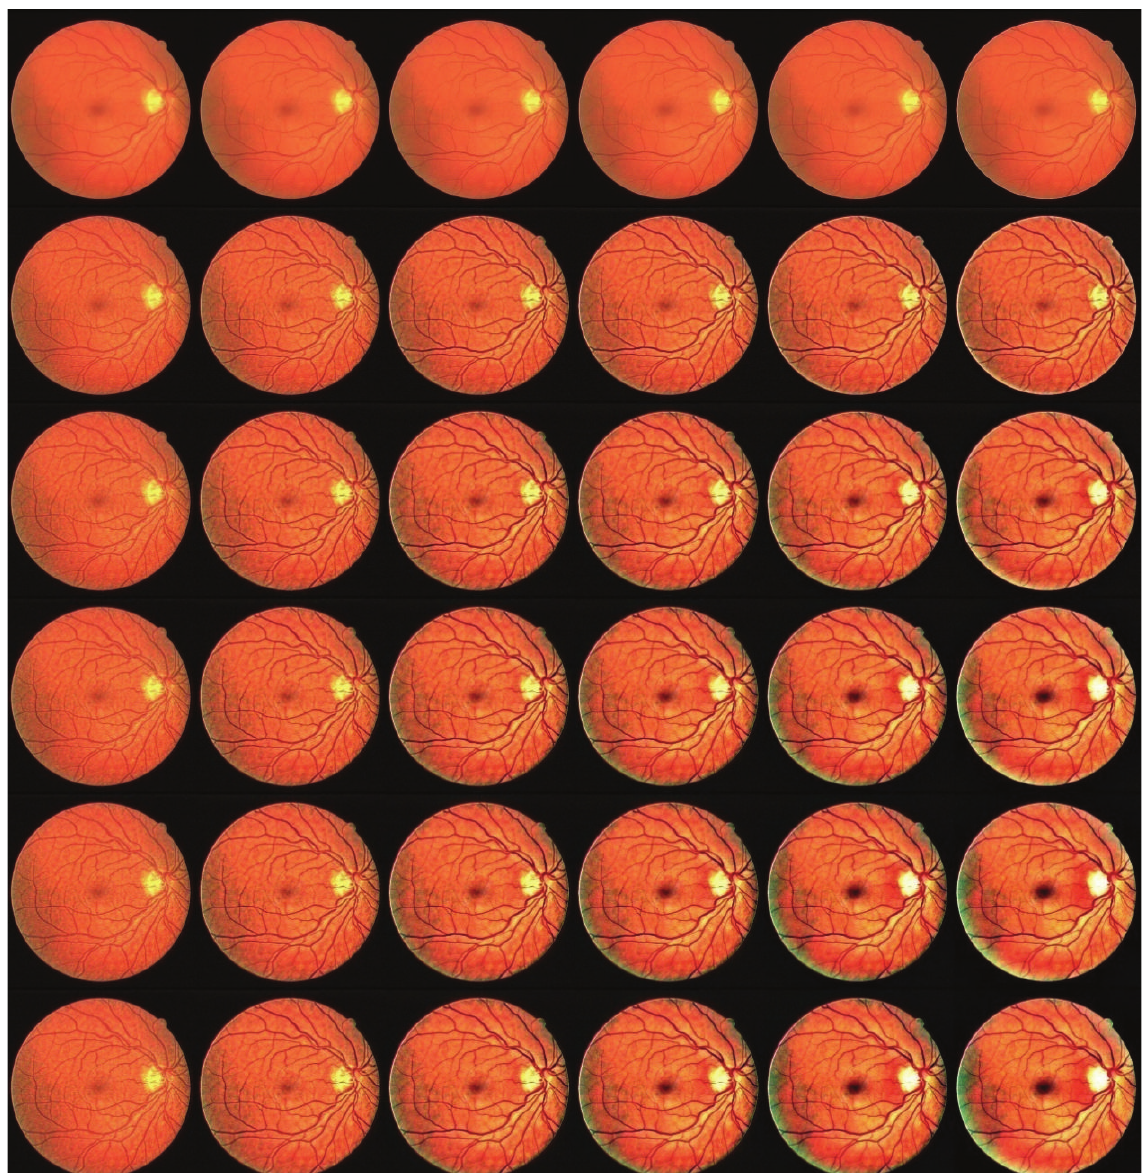
Figure 1: The enhancement results of the retinal image with different 𝜎 𝑠 and 𝜎 𝑟